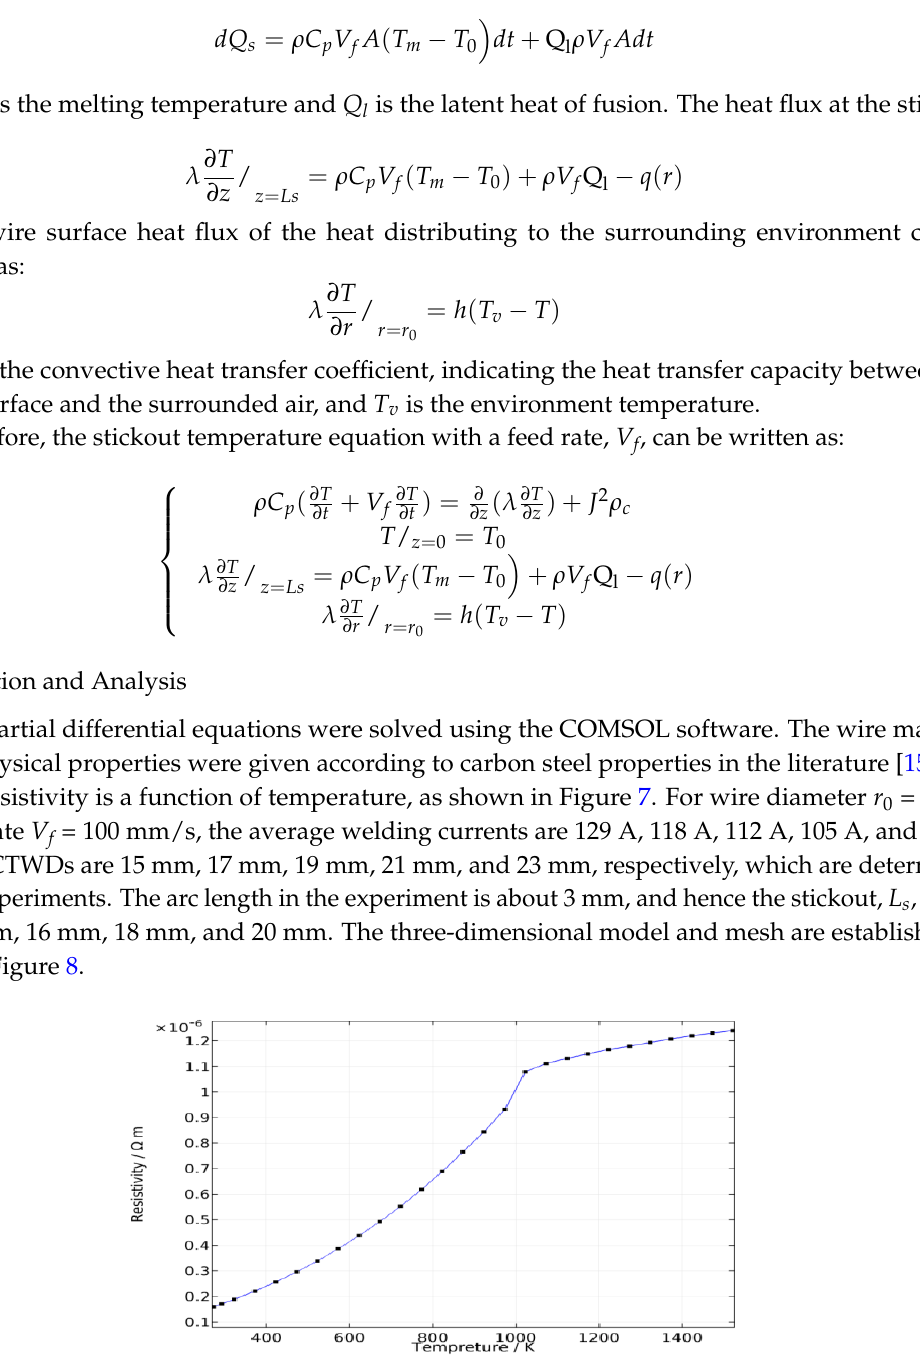
Figure 7. Carbon steel wire resistivity.